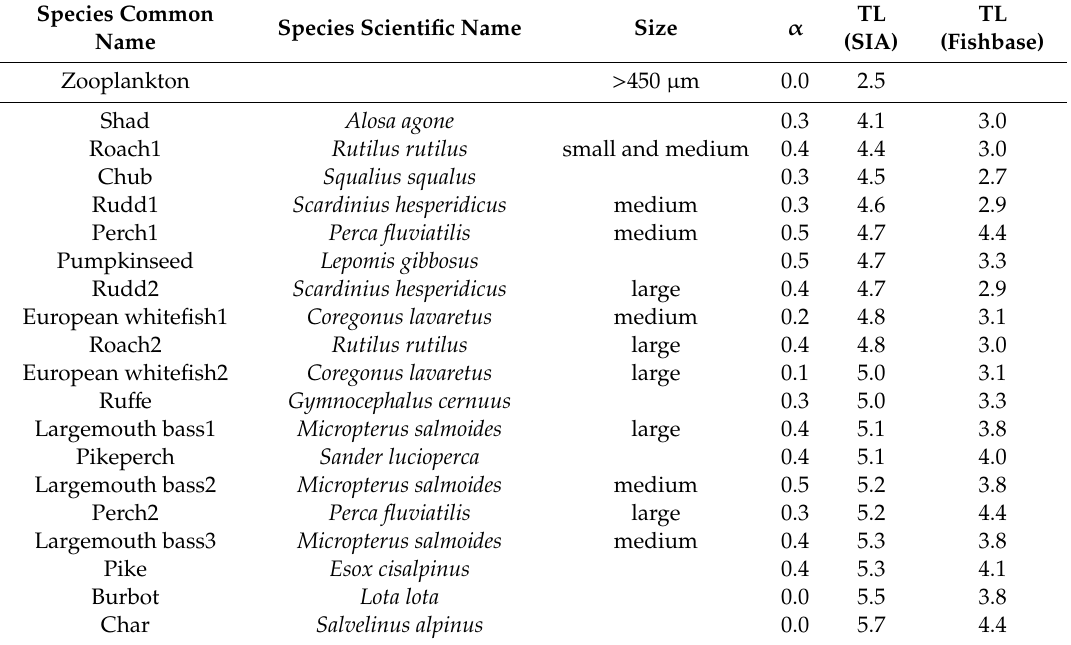
Table 1. α values and trophic levels (TL) calculated by stable isotope analysis (SIA) and derived by a literature database (www.fishbase.org) of sampled